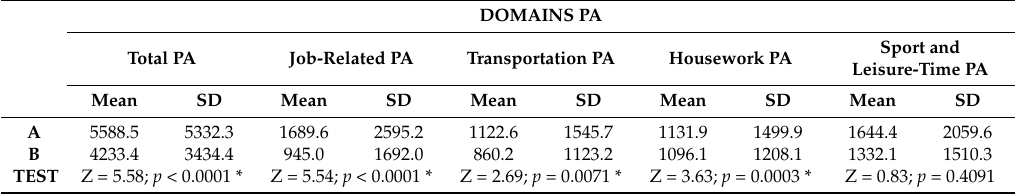
Table 2. Level of total activity and its domains by different countries (Met-min./week).